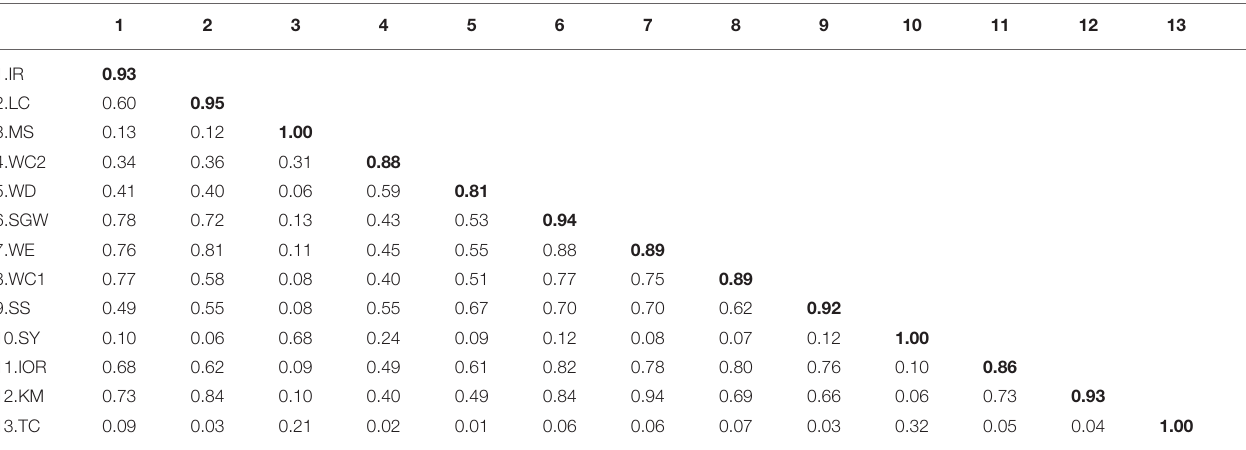
Diagonal bold boldface is the square root of AVE.